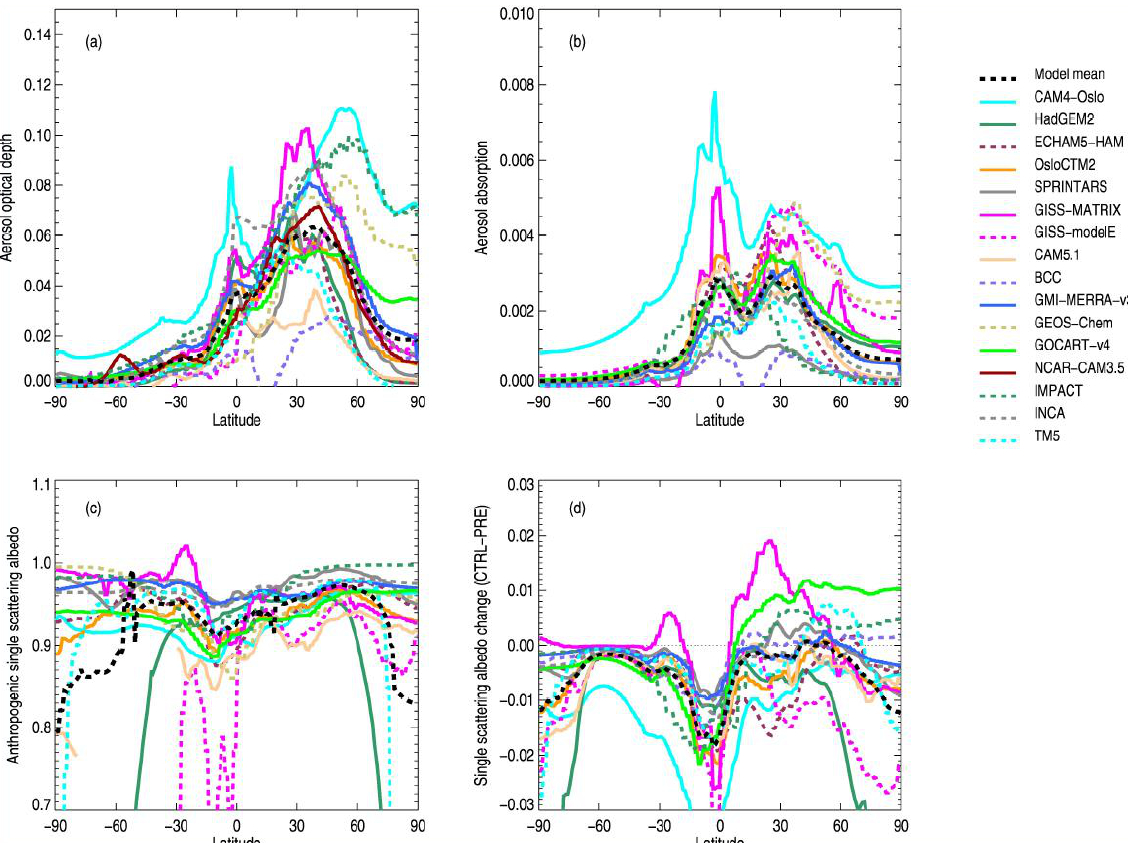
Fig. 3. Anthropogenic AOD (a) , anthropogenic AAOD (b) , anthropogenic single scattering albedo (c) , and change in single scattering albedo from pre-industrial to present conditions (d) . All values are taken at 550nm. Between 80 ◦ S and 30 ◦ S the anthropogenic AOD is extremely small for some of the models and anthropogenic single scattering albedo may reach unrealistic values and in such cases values have been removed from the